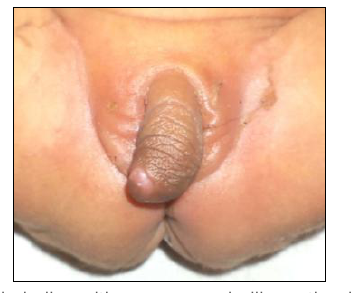
Figure 1: Enlarged phallus with accessory phallic urethra in female (46XX)